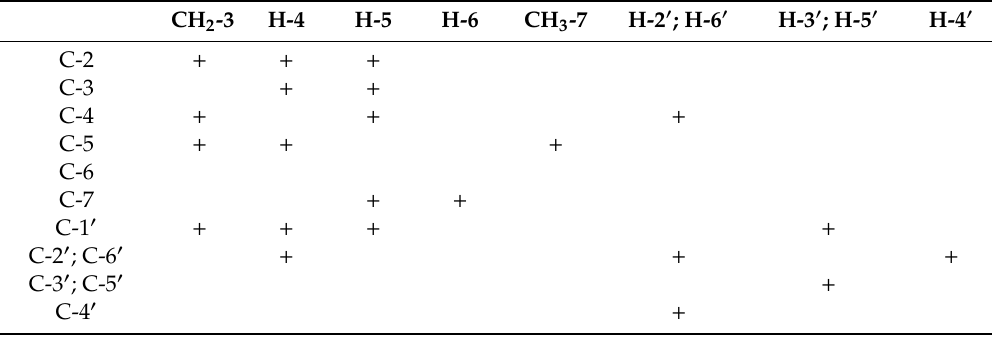
Table 1. Heteronuclear multiple-bond correlation (HMBC) data of hydroxylactone 2 .